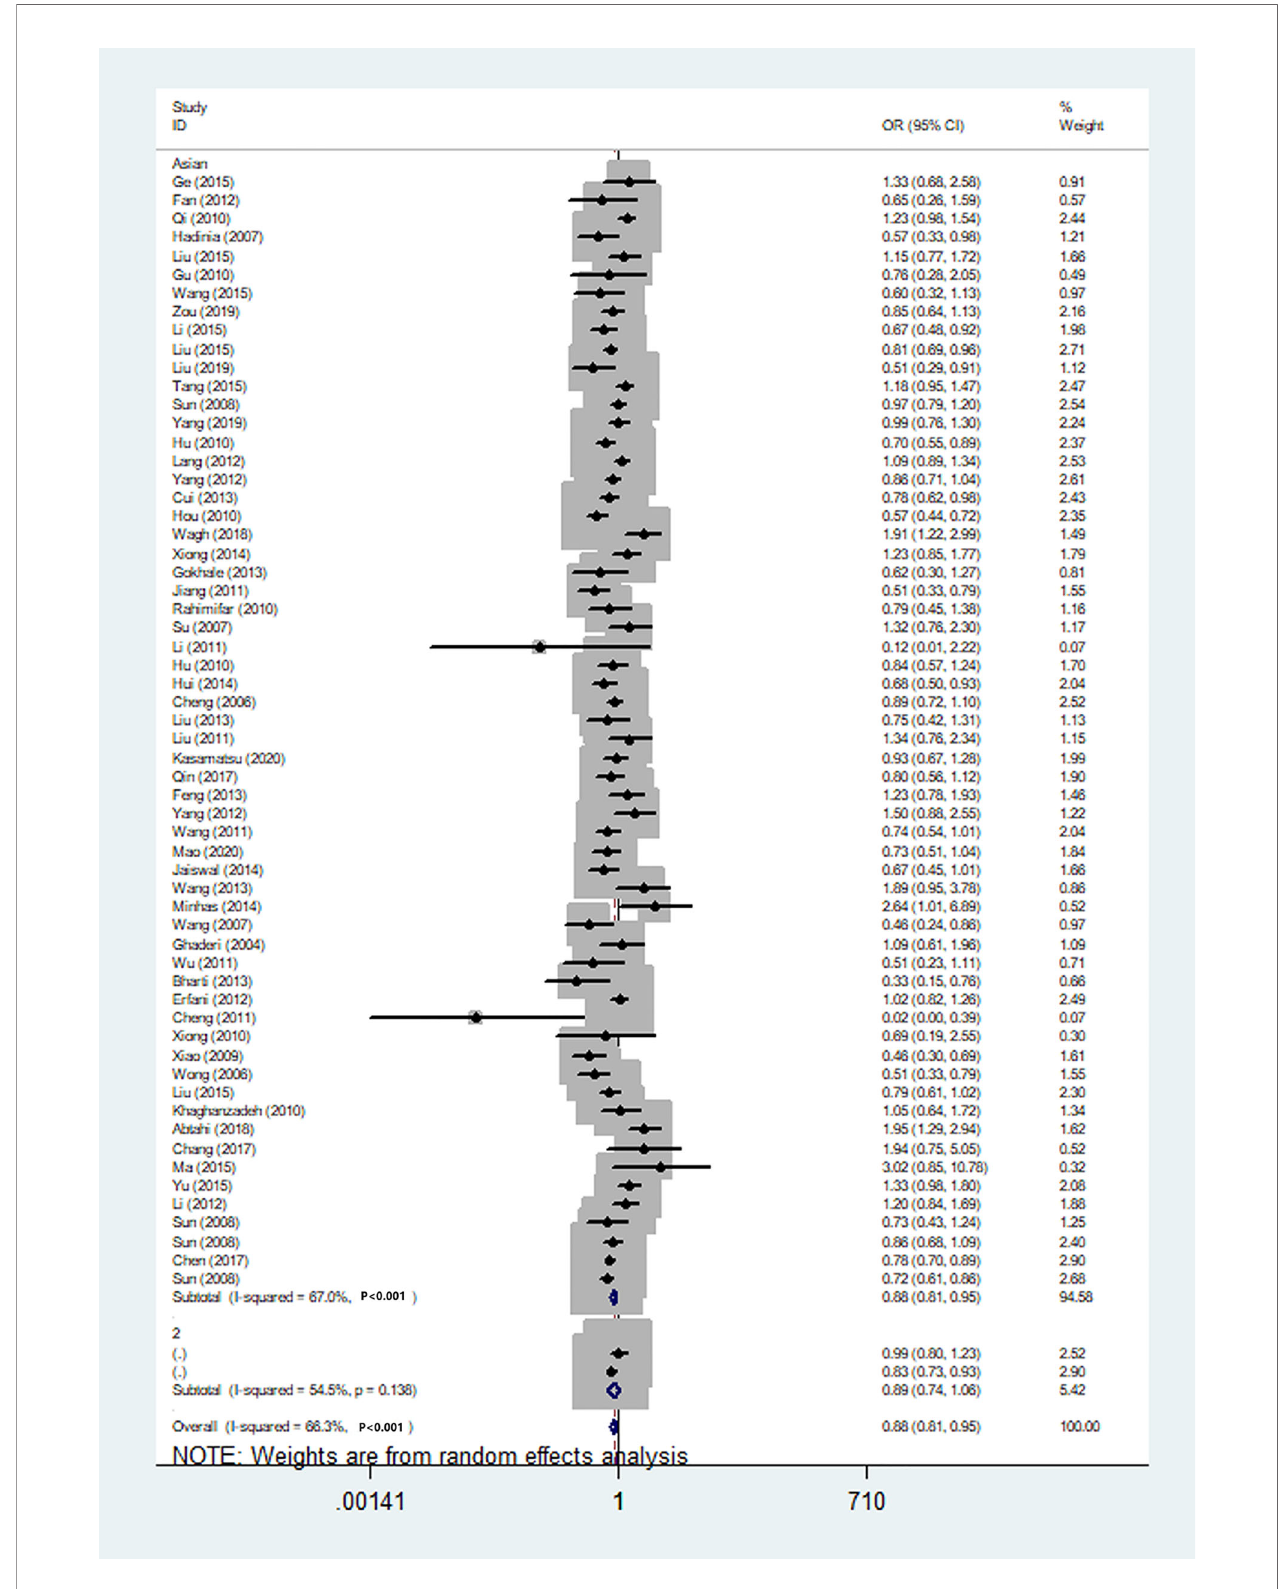
FIGURE 9 | Forest plot of cancer risk associated with the CTLA-4 gene rs231775 polymorphism in Asians (G-allele vs. A-allele model).